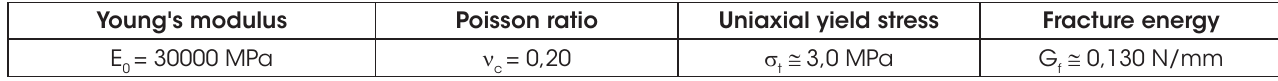
Material parameters based on the experimental results obtained by Petersson [4] Young's modulus Poisson